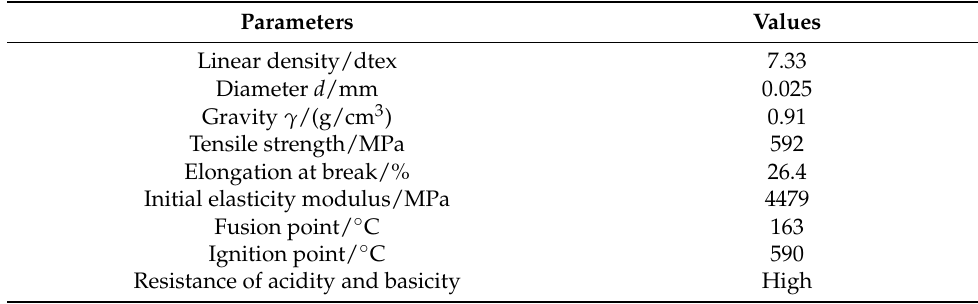
Table 2. Physical characteristics of polypropylene